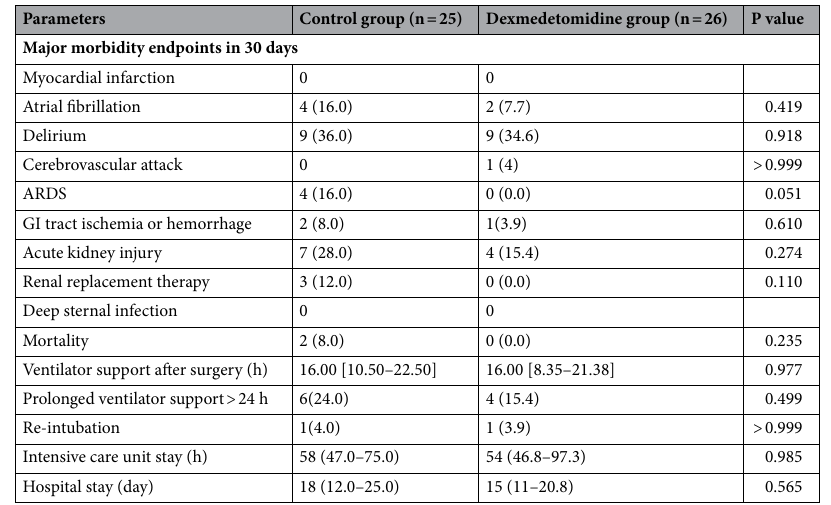
Table 3. Early postoperative morbidity. Values are shown in number of patients (percentage), mean ± standard deviation or median (interquartile range). ARDS acute respiratory distress syndrome, GI